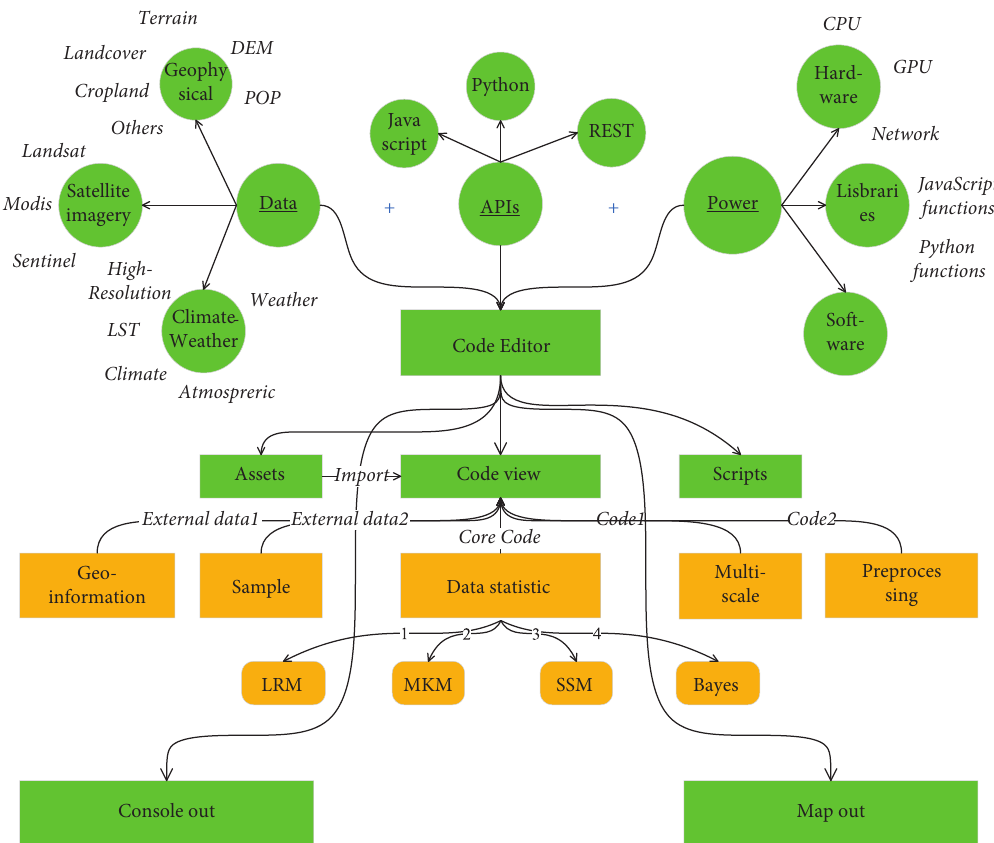
Figure 4: Integration principle of dataset, APIs, and computing power based on GEE platform in this study. The green rectangle is the GEE public sector, and the yellow rectangle is the author’s personalized